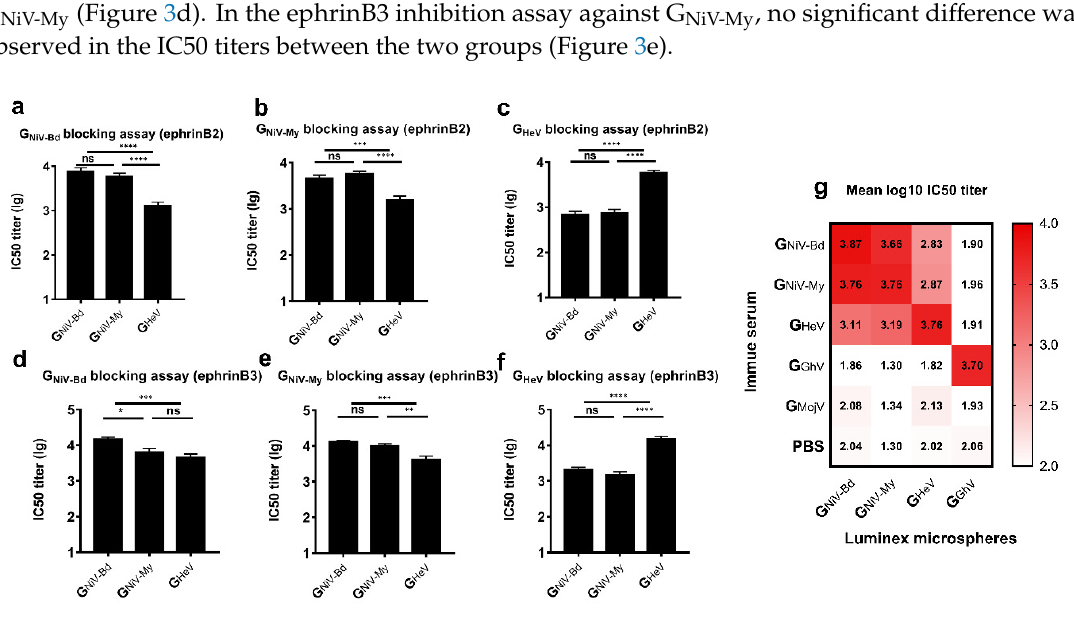
Figure 3. Cross-reactive neutralizing antibody response induced by G proteins. EphrinB2 competitive inhibition experiment against ( a ) G NiV-Bd , ( b ) G NiV-My , and ( c ) G HeV . EphrinB3 competitive inhibition experiment against ( d ) G NiV-Bd , ( e ) G NiV-My , and ( f ) G HeV . The data are presented as the mean log10 IC50 titer ± SEM. Student’s t test was performed for all comparisons, and a P -value < 0.05 was considered statistically significant; * 0.01< P -value < 0.05; ** 0.001< P -value < 0.01; *** 0.0001< P -value < 0.001; **** P- value < 0.0001. ( g ) Matrix graph of the EphrinB2 competitive inhibition experiment. The data are presented as the mean log10 IC50 titer. The same data is used in more than one panel.